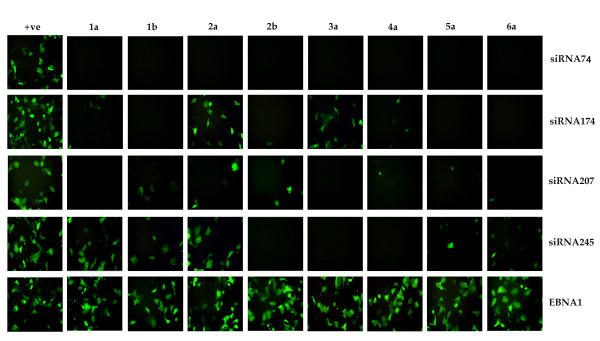
Effect of small interfering RNAs on the expression of green fluorescent protein from IRES clones of six different HCV genotypes. Huh-7 cells were co-transfected with HCVIRES-GFP plasmid with siRNA plasmid (pSuper-retro) by using the FuGENE 6 transfection reagent. After 48 hours transfected cells were observed under a fluorescence microscope. The experiments were repeated for each genotype IRES clones using different siRNA constructs. SiRNA-74 was the most effective and inhibited the expression of green fluorescence in all genotypes of HCV compared to other siRNA. Control siRNA targeted to EBNA1 had no effect on GFP expression from HCV IRES clones.